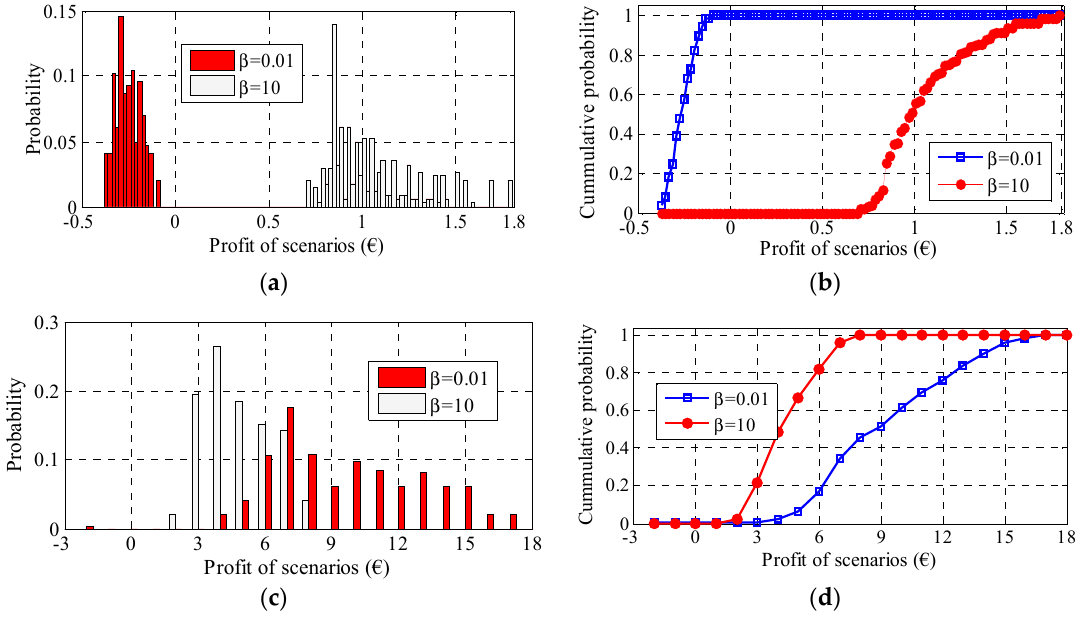
Figure 9. ( a ) The probability of profit scenarios at 19:00; ( b ) the cumulative probability function at 19:00; ( c ) the probability of profit scenarios at 22:00; ( d ) the cumulative probability function at 22:00.